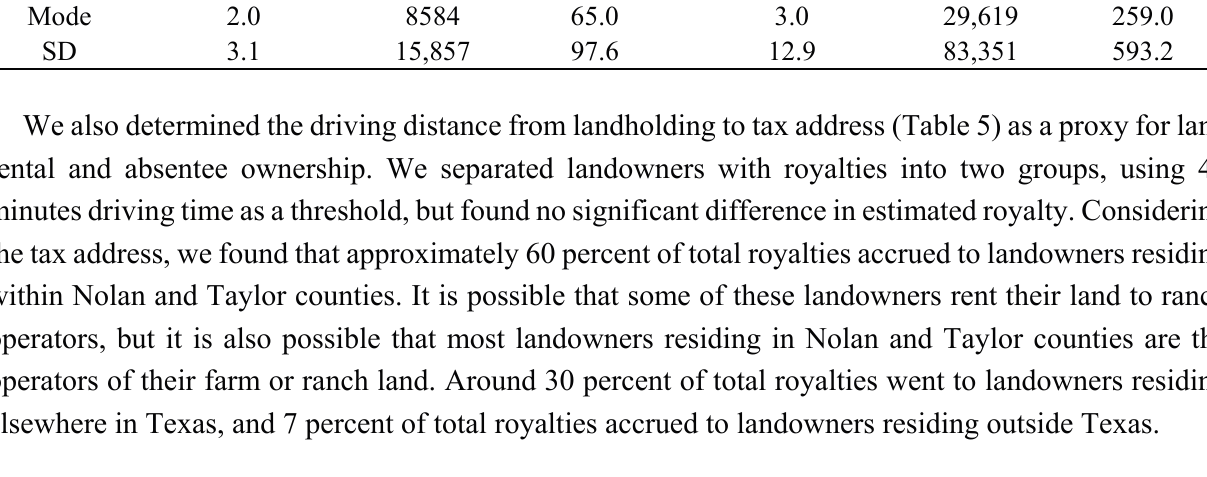
Table 5. Landholdings, turbines and estimated royalty per landholding per year according to location of tax